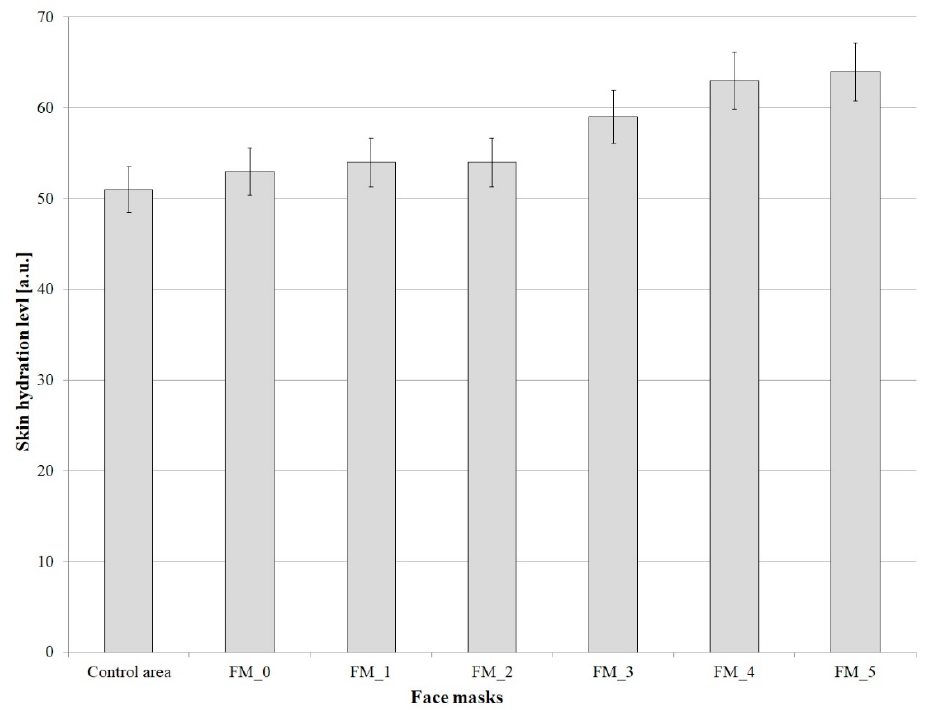
Figure 4. Skin hydration level after the application of face masks with varying concentrations of Lonicera caerulea fruit powder.